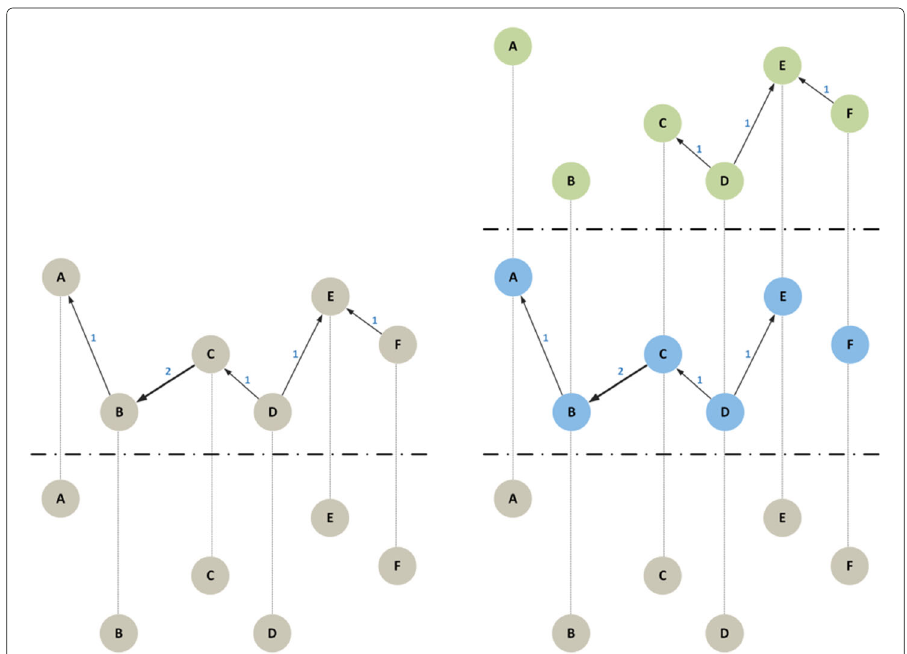
Fig. 10 Projection. ( left ) A projection of the message layers into the actor layer in the original bipartite network in Fig. 9- left . The projected multilayer network has 6 actors, 12 nodes and 5 weighted edges; ( right ) a similar projection using the 3-partite network described in Fig. 9- right which generates a multilayer network with 6 actors, 18 nodes and 7 weighted